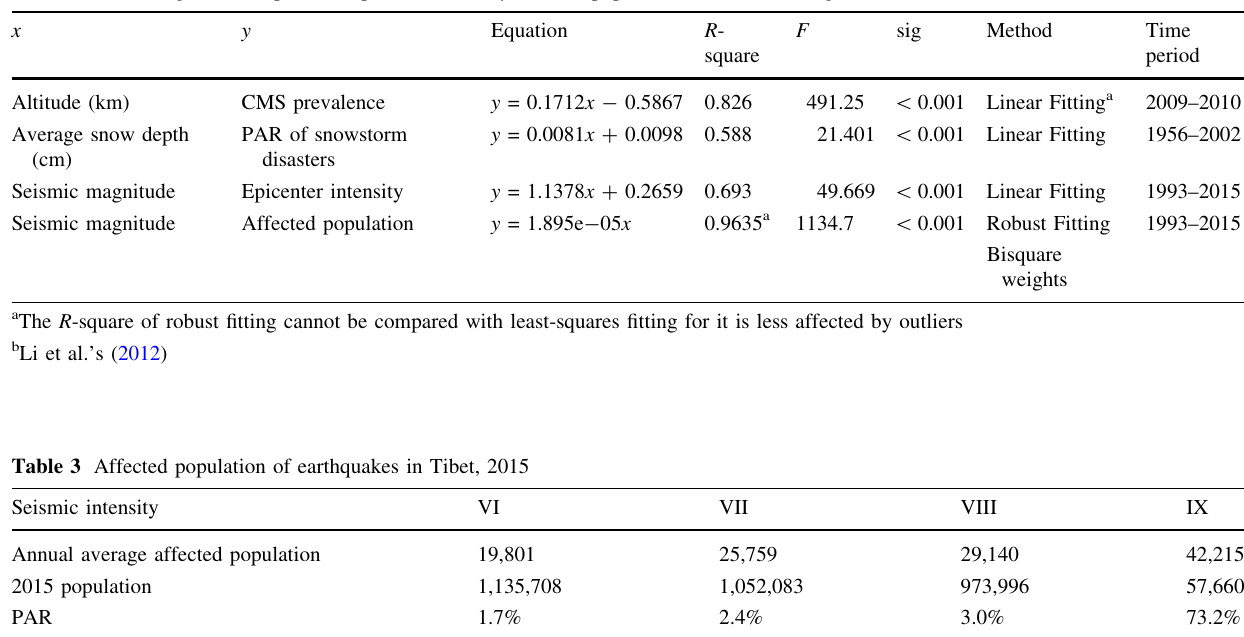
Table 2 Results of regression between chronic mountain sickness (CMS) prevalence and altitude; population affected rate (PAR) of snowstorm disasters and average snow depth; and epicenter intensity/affected population and seismic magnitude in Tibet